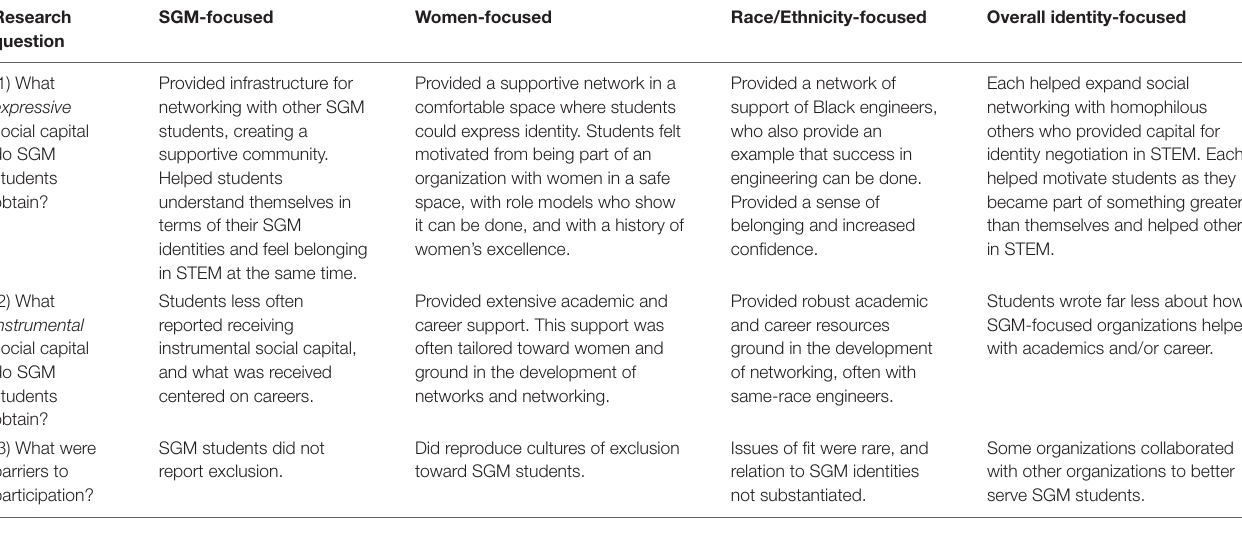
TABLE 3 | Main research findings.